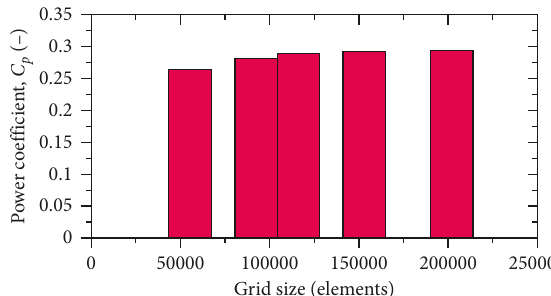
Figure 6: Mesh independence study by changing the power coefficient C